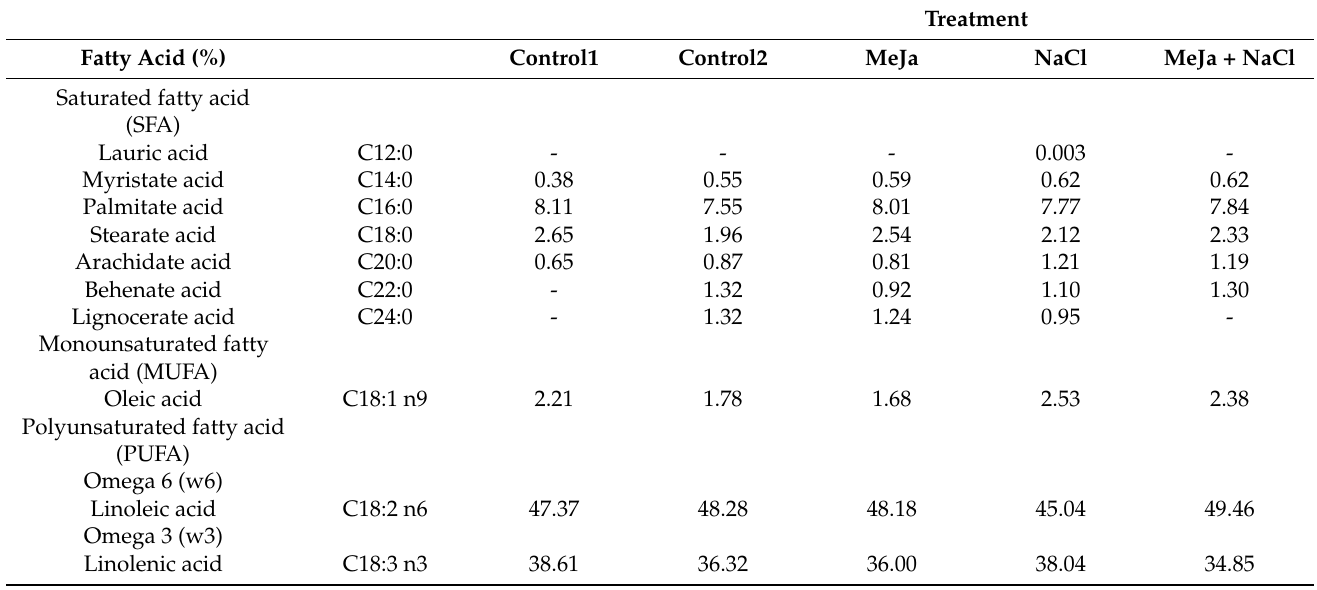
Table 5. Fatty acids content expressed as percentage of the aerial part of C. maritimum plants grown under hydroponic conditions with the following treatments: Control1, Control2, NaCl, MeJa, NaCl + MeJa, ( n =